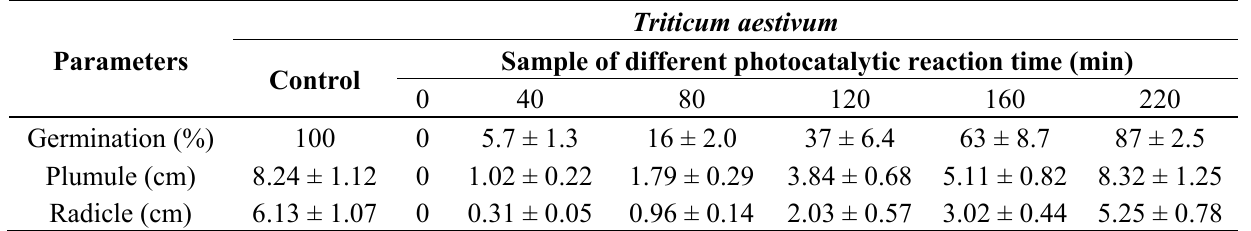
Table 5. The phytotoxicity study for Triticum aestivum seeds by using treated IC wastewater. The results are the mean of triplicates (mean ±